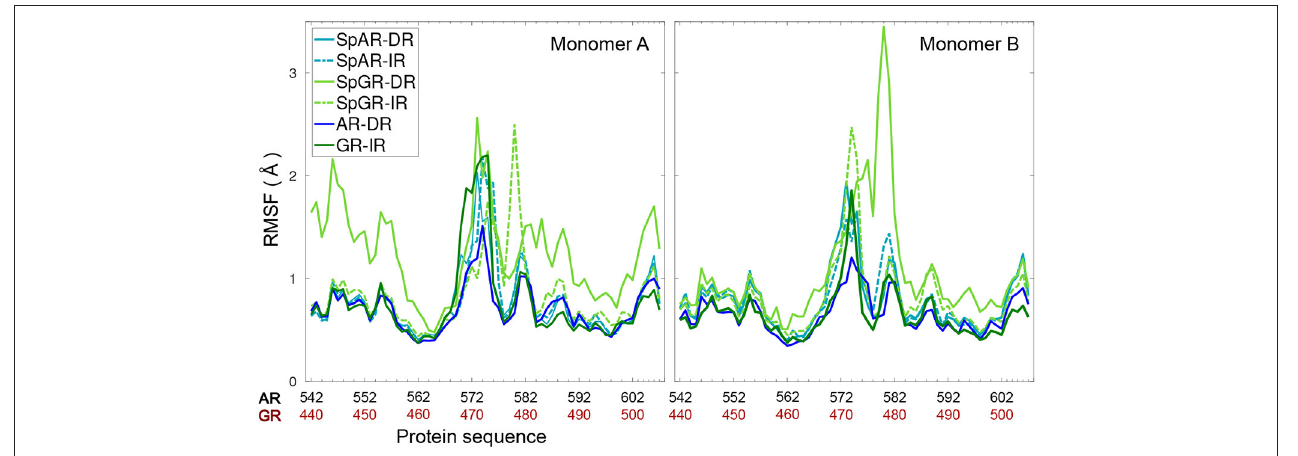
FIGURE 3 | Per-residue root mean square fluctuations of C α atoms of the protein (monomer A&B) for all systems.